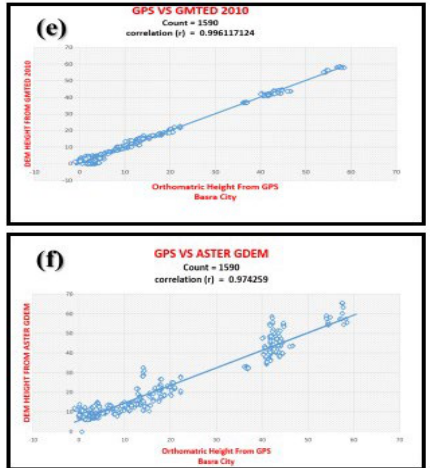
Figure 9. Scatter graphs illustrating the correlation coefficient between (a) SRTM 30m, (b) ALOS World 3D-30M, (c) NASA DEM, (d) SRTM 90M, (e) GMTED2010, and (f) Aster-GDEM elevation data and GPS